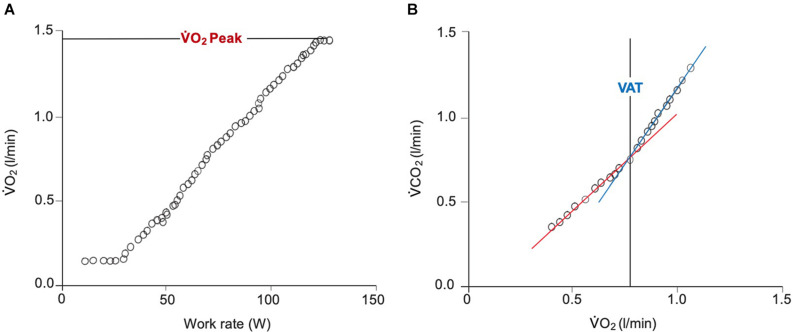
Breath-by-breath gas exchange measurements during a ramp protocol CPET. (A) Demonstrates the linear increase in V̇O2 in response to a linear increase in work rate. Achievement of V̇O2Peak is confirmed by the plateau in V̇O2 beginning at approximately 125 W. (B) Displays the derivation of the VAT using the ‘V-slope’ method. The point at which the lower (blue) and upper (red) slopes intersect indicates the VAT. V̇O2, oxygen uptake; V̇CO2, carbon dioxide output; VAT, ventilatory anaerobic threshold.